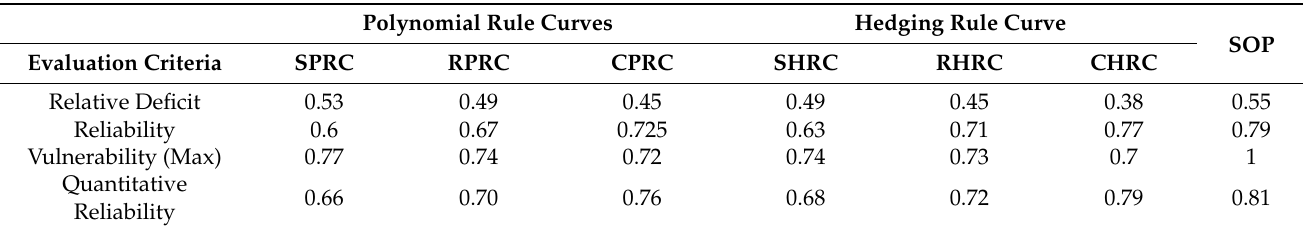
Table 5. Effects of forecast accuracy on operation